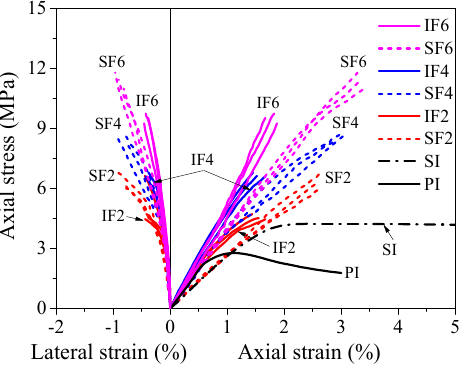
Figure 10. Axial stress vs. strain responses of the confined plain ice and sawdust-reinforced ice.